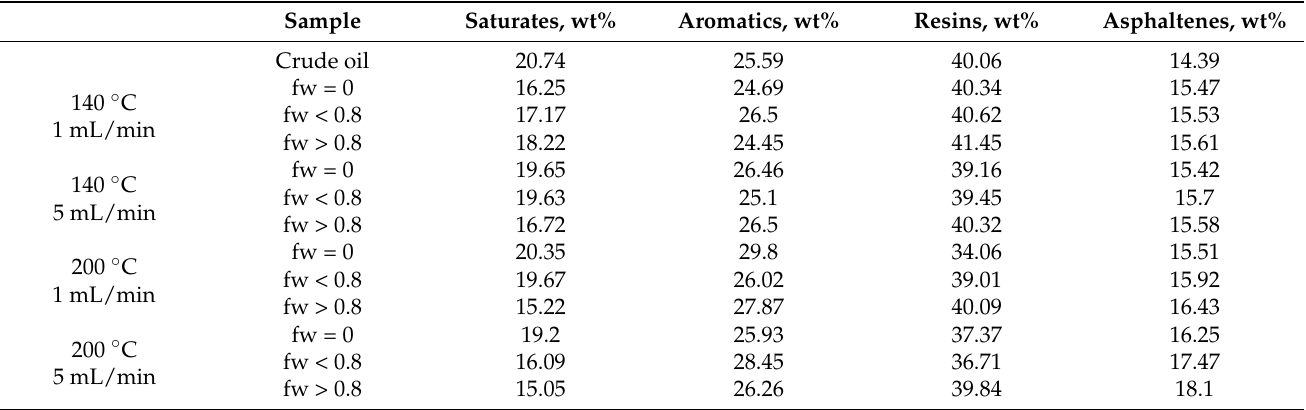
Table 3. SARA composition of the crude oil and oils produced at different temperatures and velocities of injection